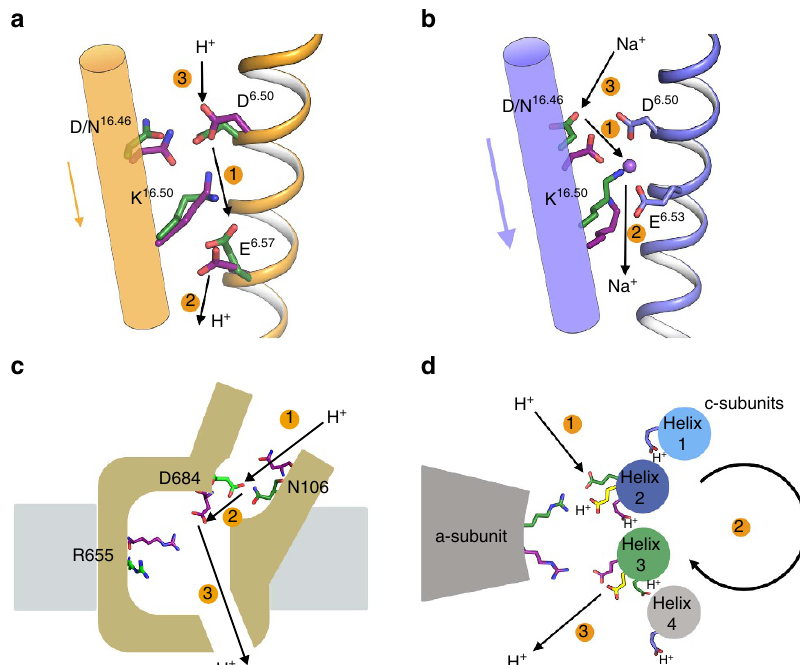
Figure 6 | Comparison of M-PPases with ATPases, demonstrating the formal similarity and the coupling of Lys/Arg motion to ion pumping. ( a ) Proton pumping and peristaltic motion of K 16.50 in VrPPase and ( b ) sodium pumping and peristaltic motion of K 16.50 in TmPPase. ( c ) Structural overview and hypothesized proton transport mechanism of P-type ATPases 31 . ( d ) Proton pumping and rotary motion in F-ATPase 29 : (based on figure 6 from reference 29) in the hydrolysis direction. Colour scheme: green, initial residue states; yellow, intermediate states; magenta, final states; blue before and after (F-ATPase). D 6.50 and E 6.53 in ( b ) and the helices in ( a , b ) are coloured as in Figs 2 and 3 to emphasize the fact that the motions there are relatively small. Numbers represent order of ion progression through the respective ion